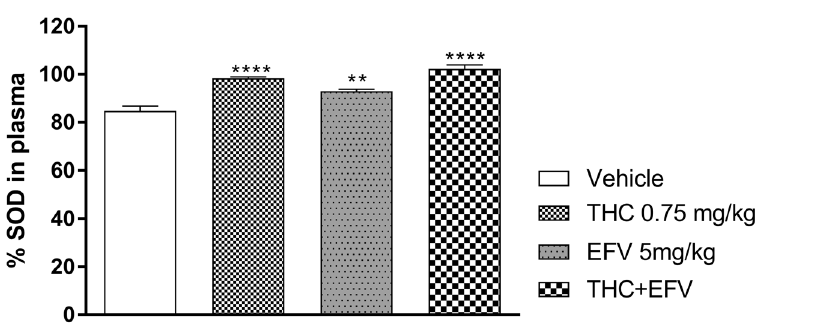
Figure 4. Peripheral percentage superoxide dismutase (%SOD) activity in the sub-chronic drug exposure groups. Tetrahydrocannabinol (THC); Efavirenz (EFV); Methamphetamine (MA). ** p < 0.01, **** p < 0.0001, vs Vehicle (One-way ANOVA, Bonferroni’s post-hoc